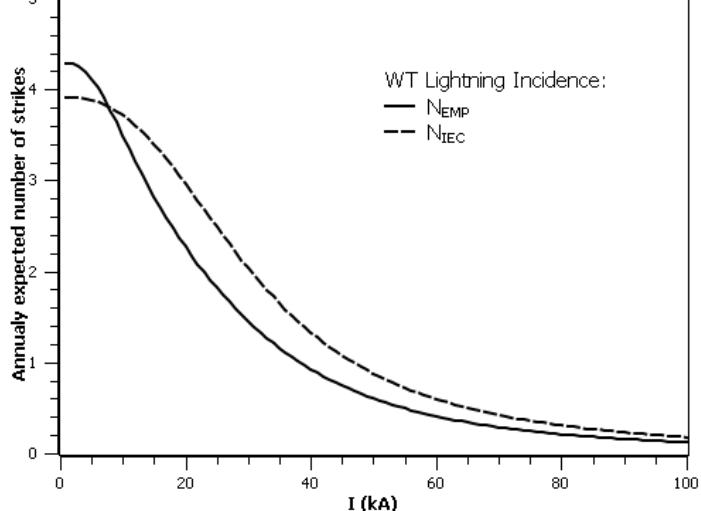
Figure 2. Comparison between wind turbine lightning incidence obtained from the IEC 61400-24 [30] and the analysis presented in